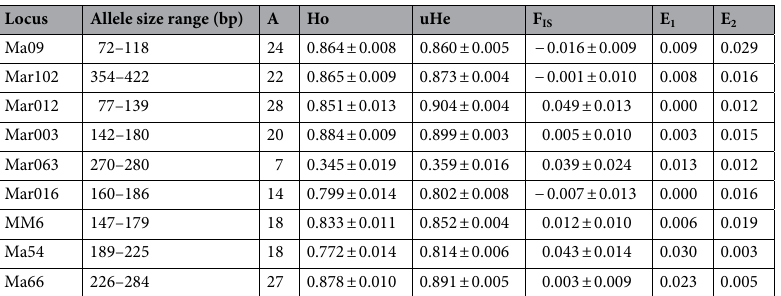
Locus Allele size range (bp) A